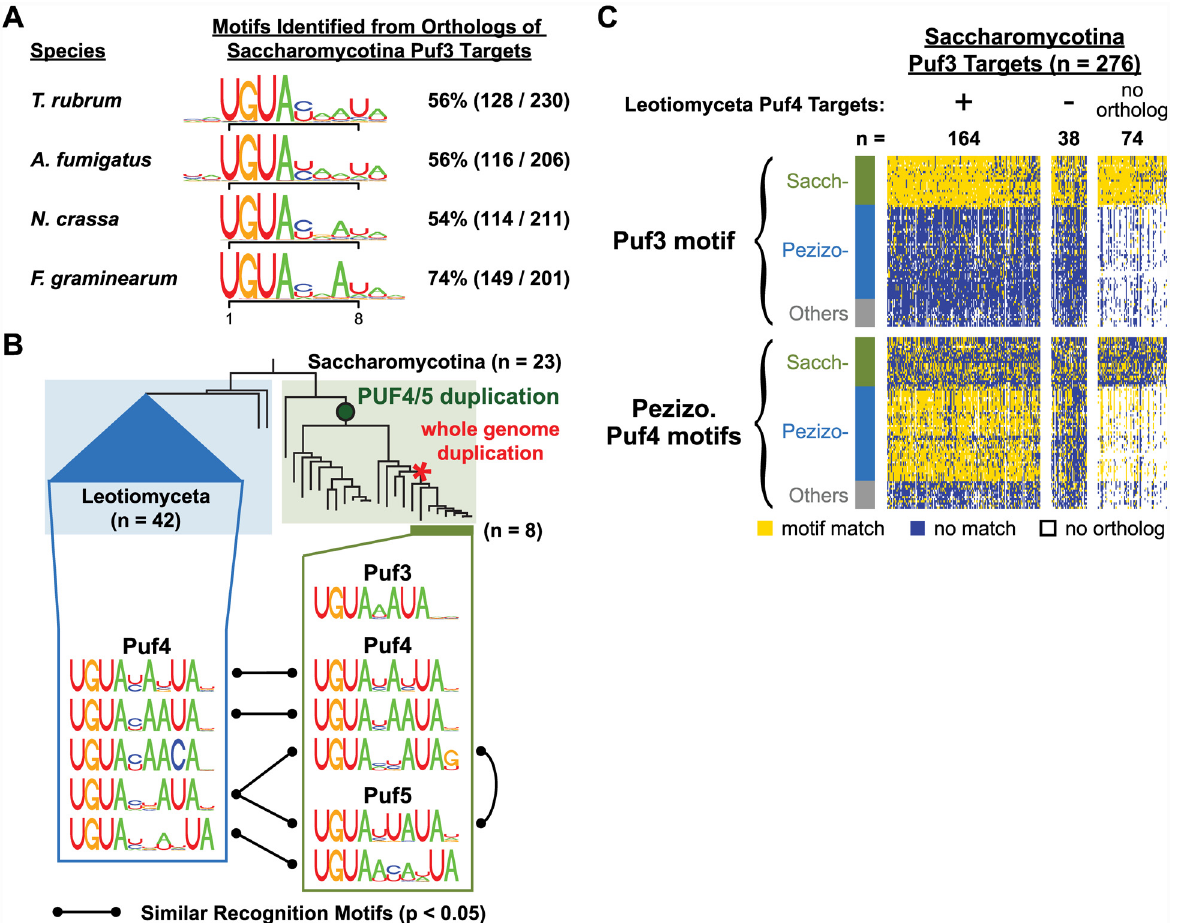
Fig 5. Evidence for Pezizomycotina Puf4 binding to RNA orthologs of Saccharomycotina Puf3 targets. (A) Motifs identified by the motif discovery program REFINE [61] using the 3' UTRs of orthologs of conserved Saccharomycotina Puf3 targets. Representatives spanning the Leotiomyceta lineage are shown. Numbers on the right indicate how many orthologous RNAs of Saccharomycotina Puf3 targets contain a match to the identified motif. All significant motifs found across the 80 fungi are displayed in S8 Fig, a summary of significance testing can be found in S11 Table, and position frequency matrices can be found in S5 Dataset. (B) Characterization and comparison of Puf binding specificity in Leotiomyceta and Saccharomycotina. Saccharomycotina Puf motifs were identified from S . cerevisiae Puf targets [25] and their orthologs in the seven closely related species up to S . castelli . The Pezizomycotina Puf motifs were identified from orthologs of conserved Saccharomycotina Puf3 targets in Leotiomyceta species. Our approach involved first identifying ten nucleotide sequences (containing UGUA at the 5' end and six other nucleotides) that help discriminate a Puf protein's RNA targets from its nontargets. These informative sequences were then clustered and assigned into groups (Materials and Methods). A black line between motifs indicates similarity in the non- UGUA positions as identified by MotifComparison [84]. For simplicity, a motif can only make one connection to another protein ’ s collection of motifs, and the motifs with higher similarity were given priority. Position frequency matrices can be found in S5 Dataset. (C) Heatmaps showing the prevalence of RNAs containing sequences recognized by Puf3 or Pezizomycotina Puf4. Each row represents results from one species, and each column represents an ortholog set. Ortholog sets for conserved Saccharomycotina Puf3 targets are shown and divided into groups based on whether the ortholog set is among the Leotiomyceta Puf4 targets. The third group contains Saccharomycotina Puf3 targets that did not have an ortholog in N . crassa . Complete motif search results can be found in S8